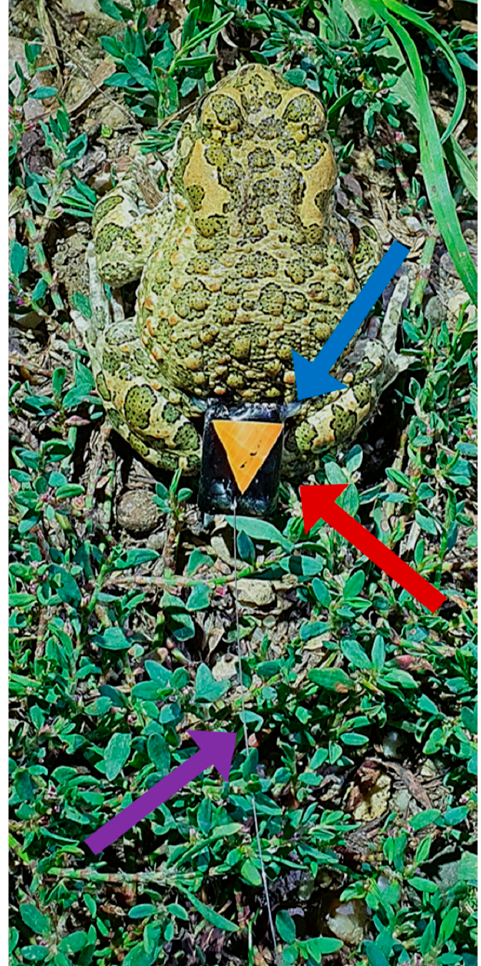
Figure 1. The tracking device attached to toad number K1 (male, mass: 35 g, snout-vent-length: 73 mm). The blue arrow points towards the silicon tubing (fastened using pre-made grommets) used to secure the tracking devices to the animal. The red arrow shows the tracking device and the purple arrow indicates the antenna (maximum length: 15.5 cm). Labels, in this case a yellow triangle, were used on each device to reliably distinguish between individual tracking units.